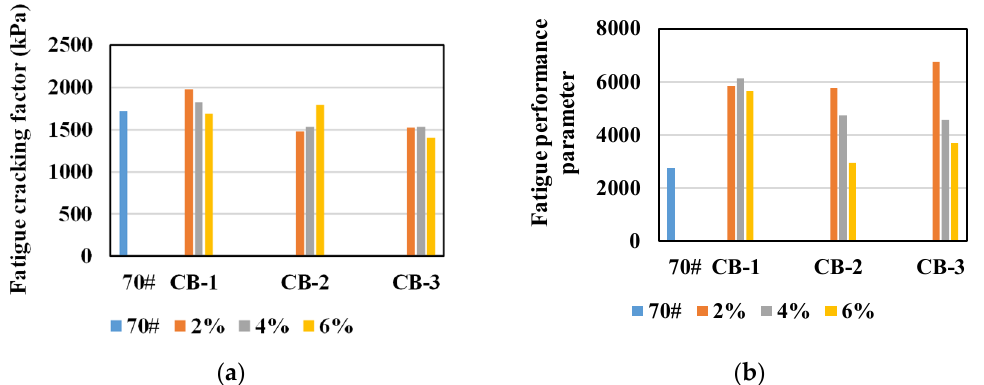
Figure 10. Fatigue cracking factor and fatigue performance parameter of asphalt after PAV aging: ( a ) fatigue cracking factor; ( b ) fatigue performance parameter.